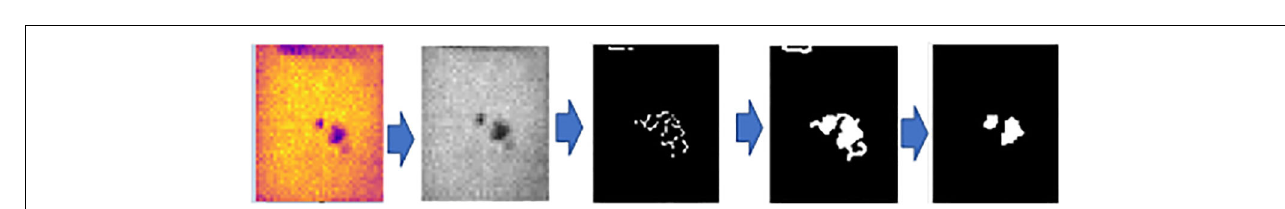
FIGURE 11 | Sample result detection of lightning defect using Canny edge detection algorithm.